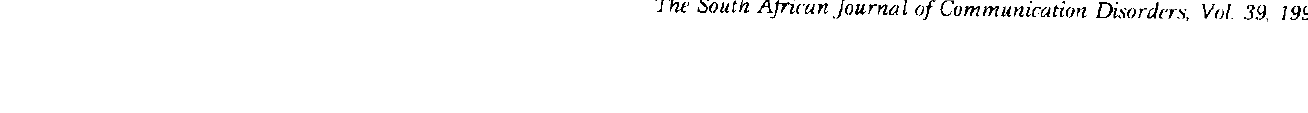
Figure 10: Who should teach disabled people to communicate? some positive impact on the